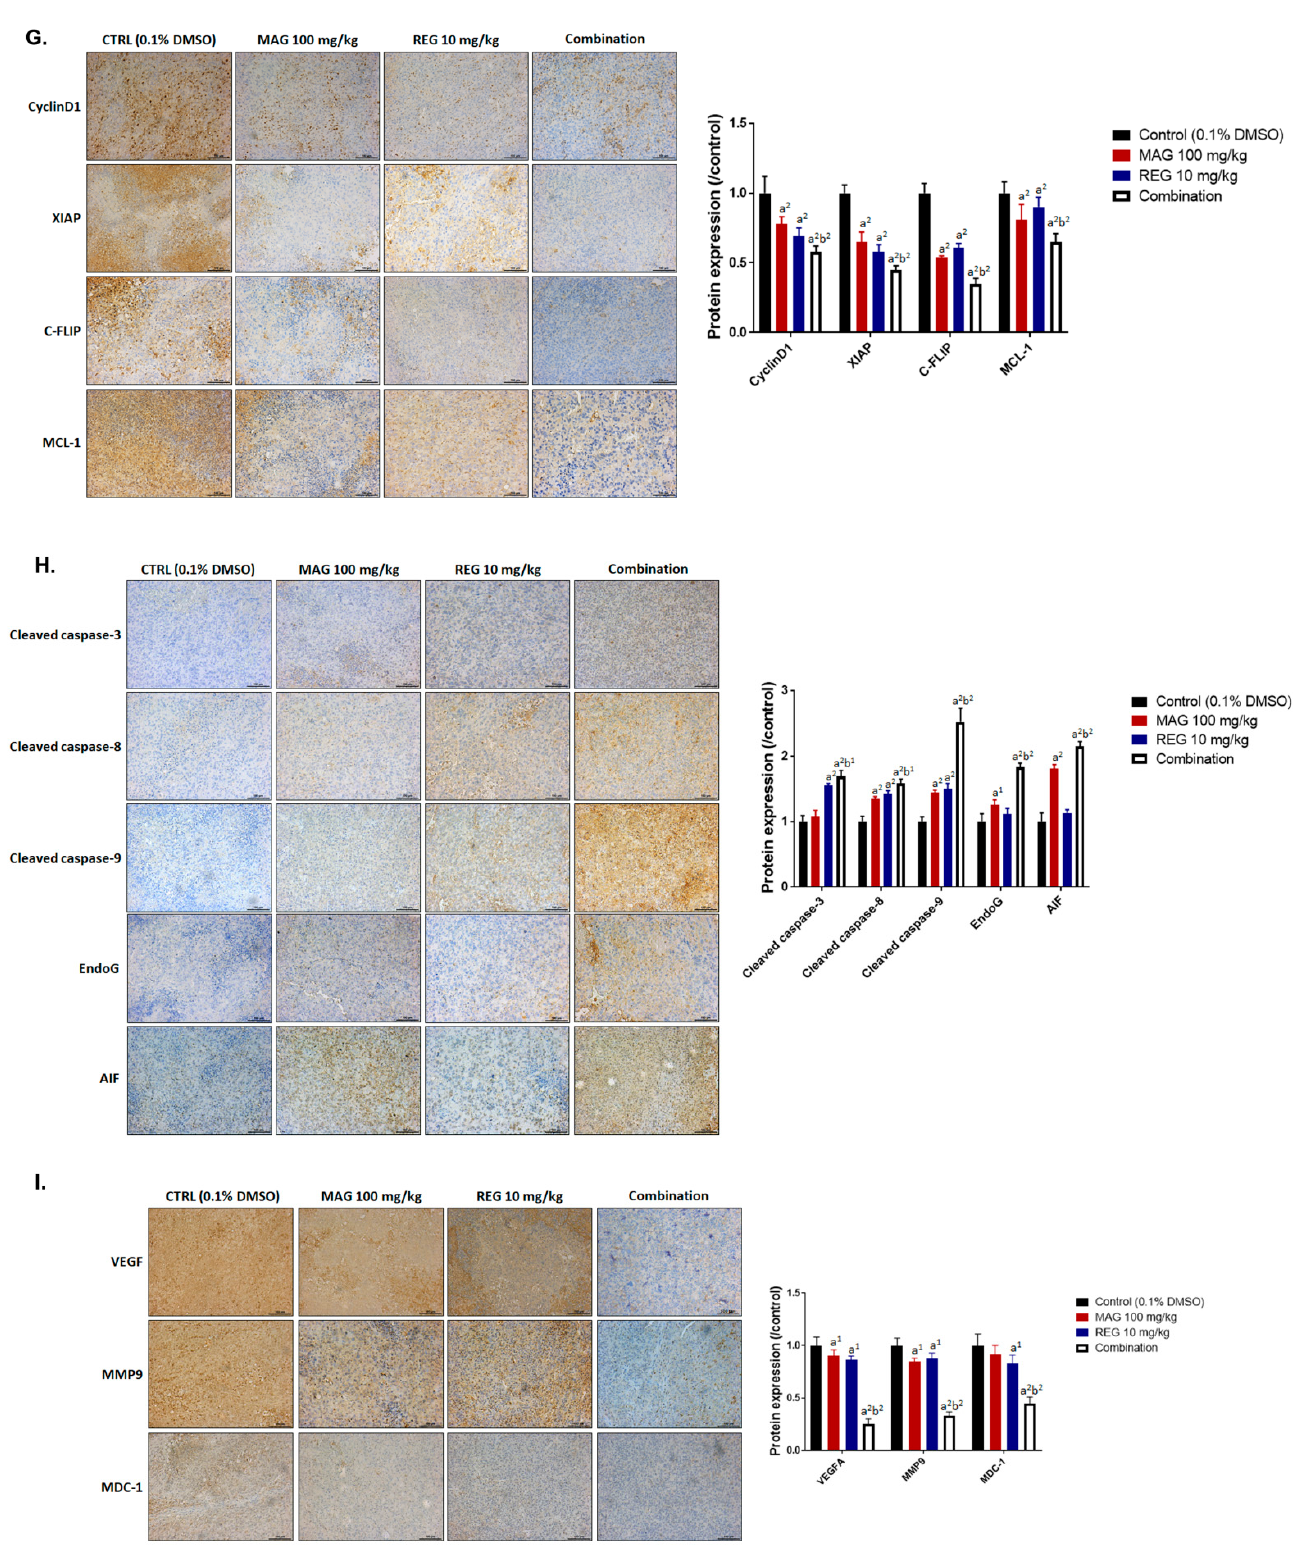
Figure 6. The therapeutic efficacy of regorafenib in Hep3B-bearing mice was enhanced by magnolol. ( A ) The tumor volume and ( B ) photographs and ( C ) weight are displayed after various treatments. ( D ) Micro-CT scan images, ( E ) mice body weight, and ( F ) an H&E stain of the liver, kidneys, and spleen are presented. IHC stain against ( G ) tumor progression, ( H ) apoptosis, ( I ) metastasis- and DNA repair-related antibodies are shown in the tumor tissue of each group. (a 1 p < 0.05 and a 2 p < 0.01 vs. CTRL; b 2 p < 0.01 vs. 10 µ M REG or 50 µ M MAG; scale bar = 100 µ